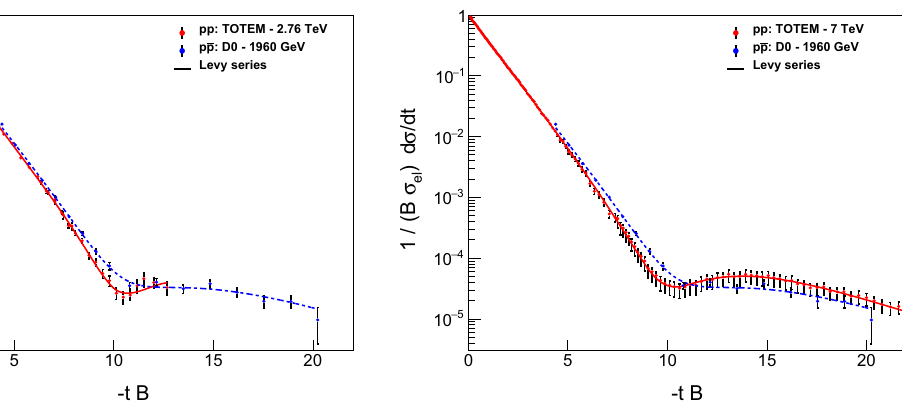
√ s = 1 . 96 TeV (blue).